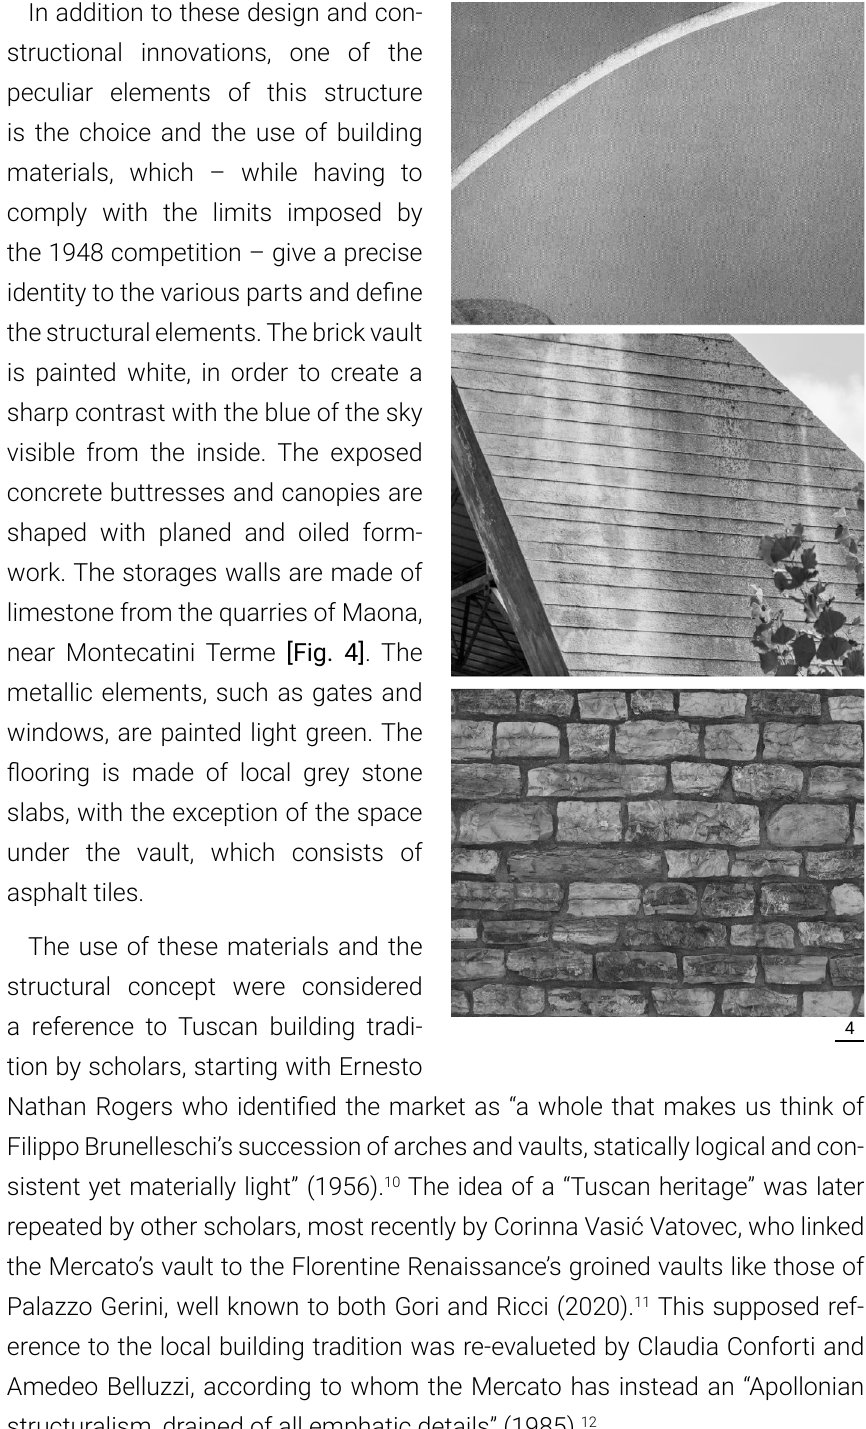
Mercato dei Fiori, Pescia. Top: detail of the vault intrados; center: detail of the reinforced-concrete lateral buttresses supporting the vault; bottom: detail of the walls of the storages, made of limestone from the Maona quarries.